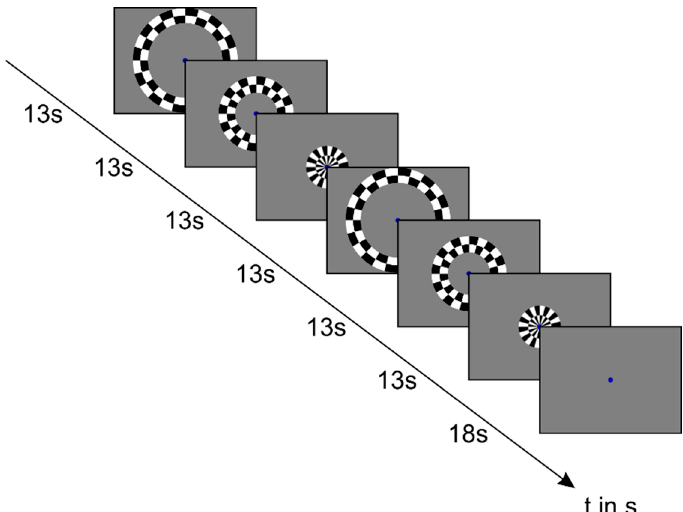
Figure 1. Stimulation procedure for patients and control subjects during eccentricity mapping. The flickering checkerboard patterns were presented in blocks of 13s and the baseline condition in blocks of 18s. The visual stimuli consisted of black-and-white checkerboard patterns (1 cd/m 2 and 330 cd/m 2 , respectively) with a flicker rate of 8 Hz, which were continuously presented as a central (0.8–9° visual angle), middle (9–17° visual angle) and peripheral (17–24.2° visual angle) circle on a grey background of medium luminance in a block design, together with a baseline condition (grey background of medium luminance). During the presentation of the circles, the subjects should fixate a cross or blue dot in the middle of the screen.